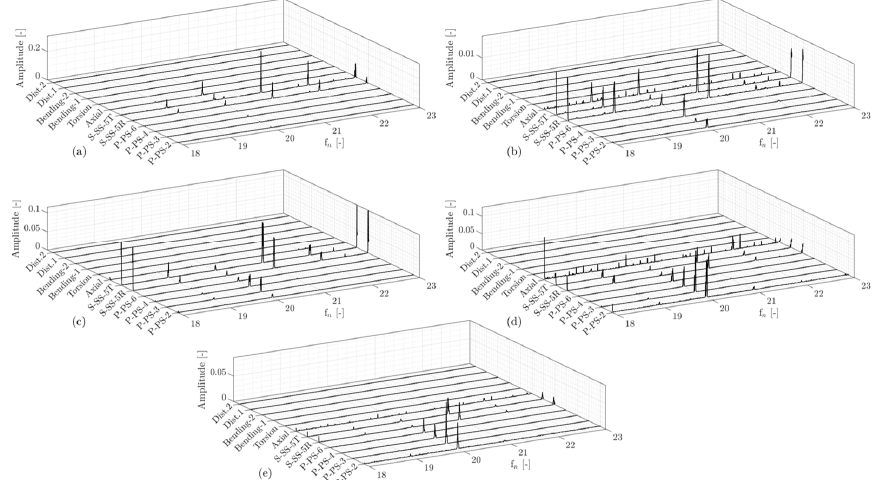
Figure 18. Amplitude spectra of pressure, strain, and displacement data obtained on the runner blade and shaft at high-frequency region; ( a ) OP6, ( b ) OP7, ( c ) OP8, ( d ) OP9, and ( e ) OP10. ‘Dist.1 ′ and ‘Dist.2 ′ denote the first and second proximity probes.